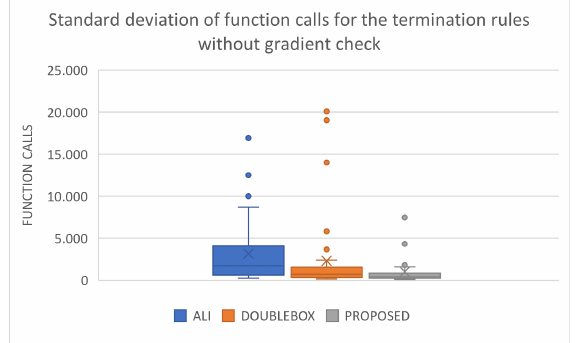
Figure 1. Standard deviation of function calls for the termination rules without the gradient check.